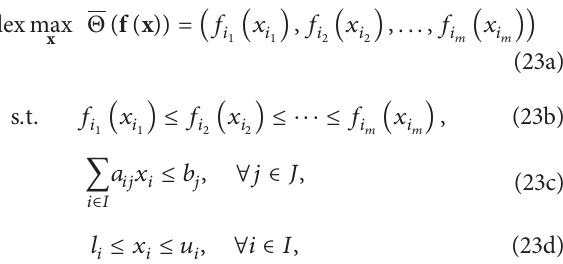
Figure 5: Multiple path for demand between nodes 1 and